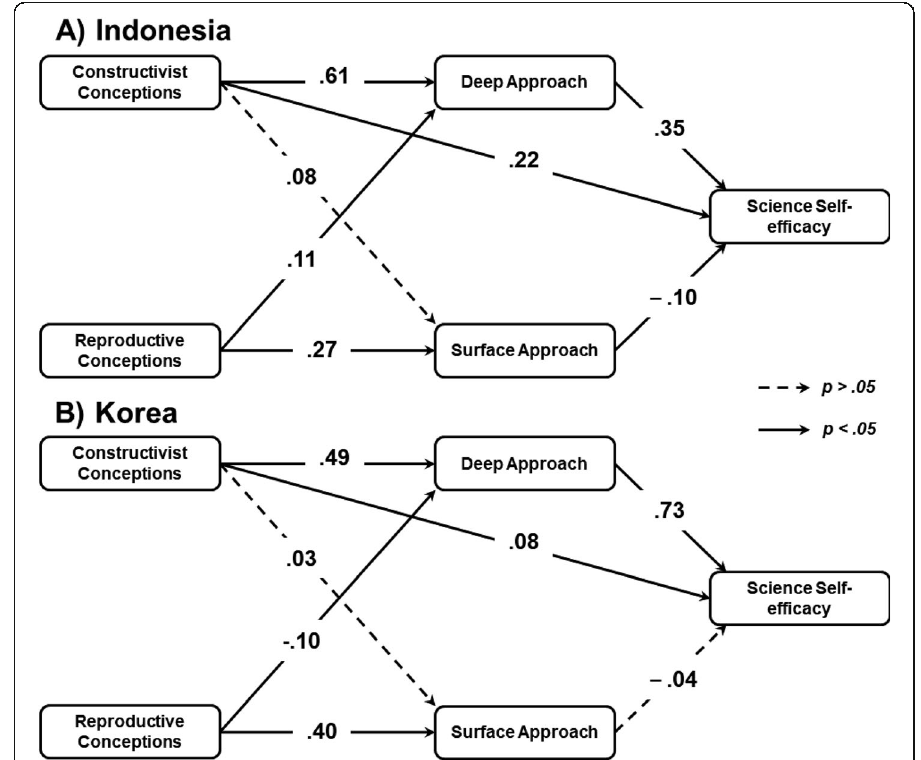
Fig. 3 The comparison between Indonesian and Korean's path